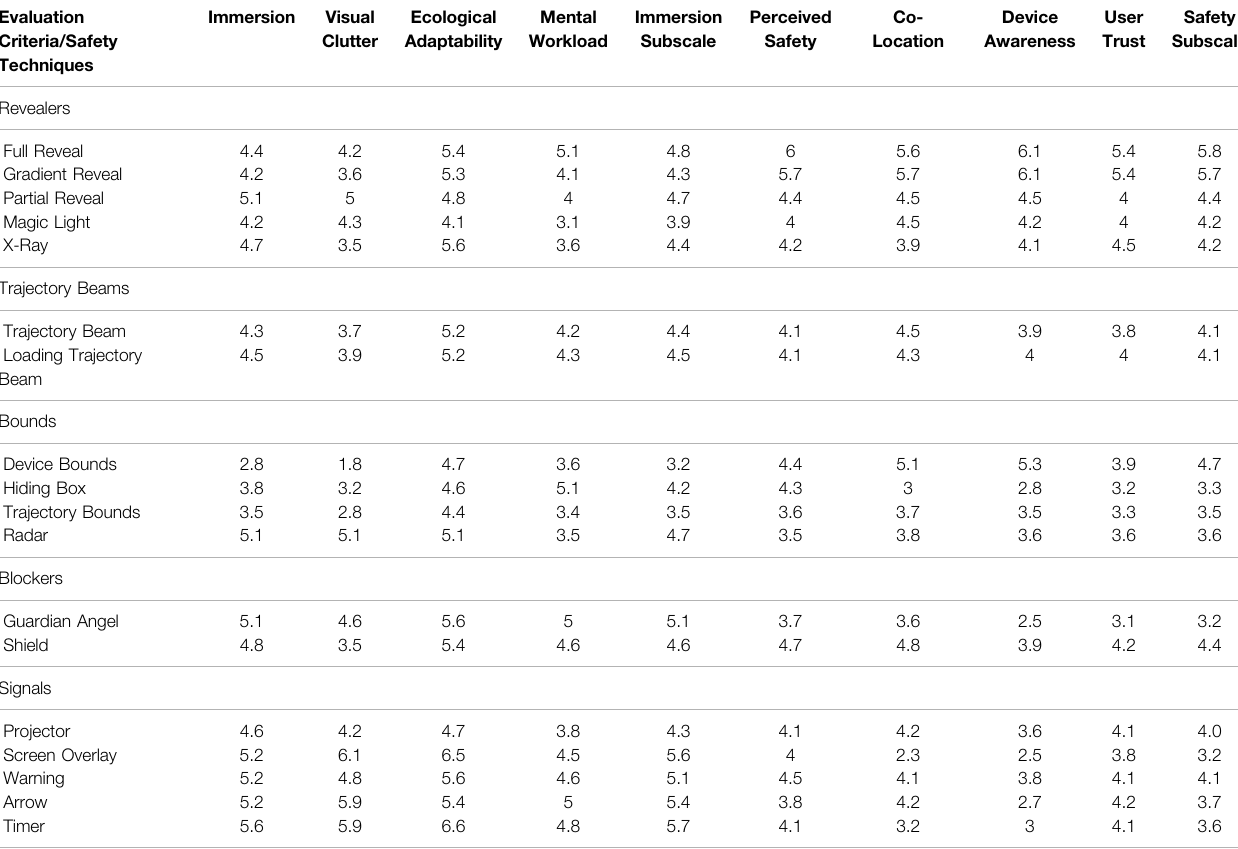
TABLE 3 | Average response scores for all the techniques and all the evaluation criteria. The three highest values are highlighted in blue while the three lowest values are highlighted in